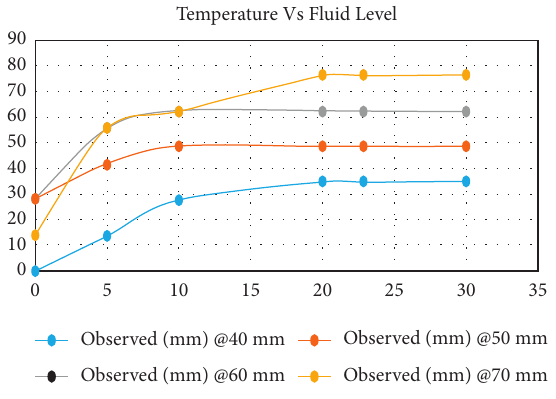
Figure 23: Temperature vs. fluid